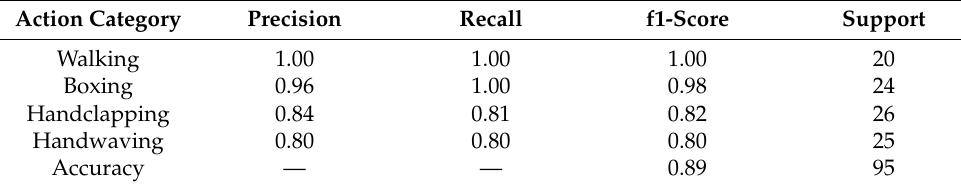
Table 5. Classification results for Raw using KNN-DTW with KTH-4. Action Category